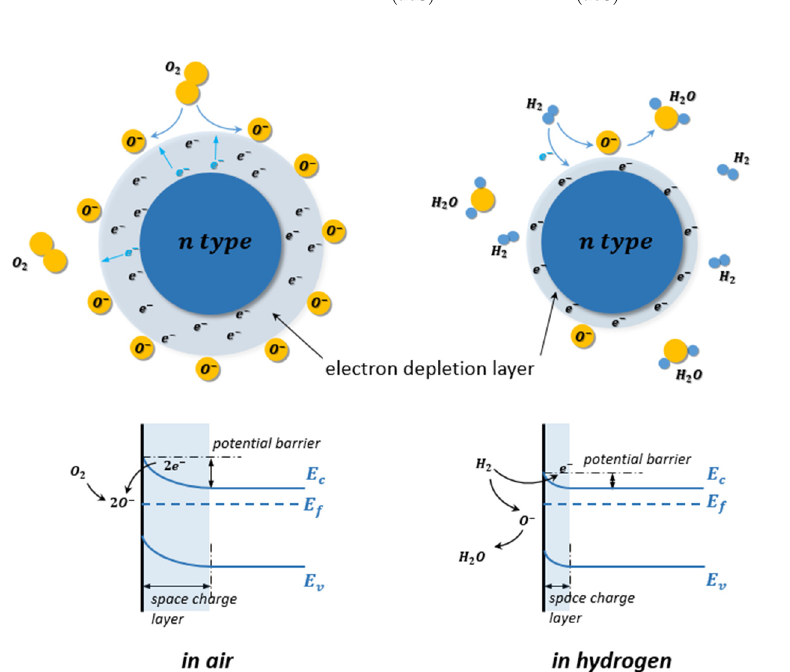
Figure 19. Schematic illustration of the gas sensing mechanism of n-type metal oxide semiconductor (MOS) and its energy band change in the air and hydrogen.